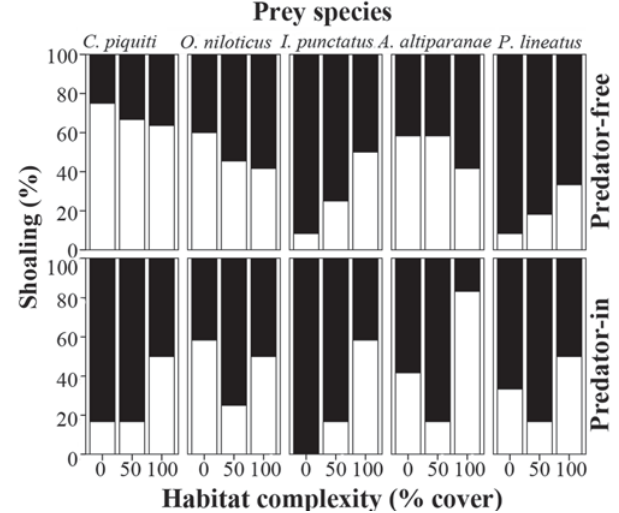
Fig. 5. Refuge use (%) by prey species in response to predator presence ( P. corruscans ) in 50% complexity treatments. White square = not sheltered, black square = entirely sheltered within the artificial vegetation. Top panel = predator-free; bottom panel = predator-in treatments.